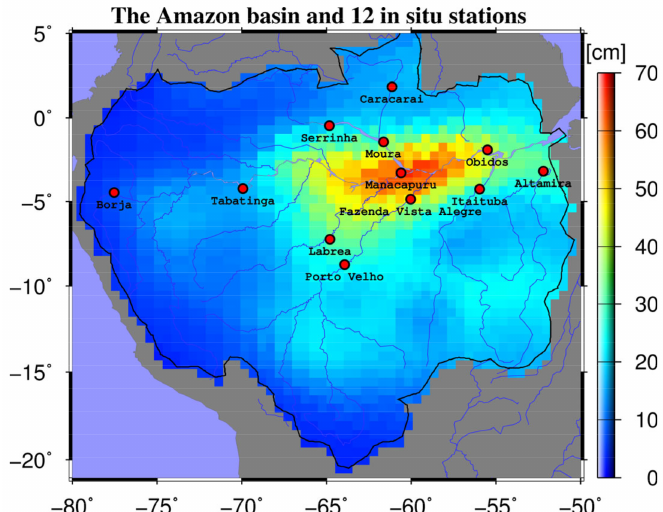
Figure 1. Location map of 12 in situ gauge stations over the main Amazon tributaries, superimposed by the root mean square (RMS) of Center for Space Research (CSR) mascons.